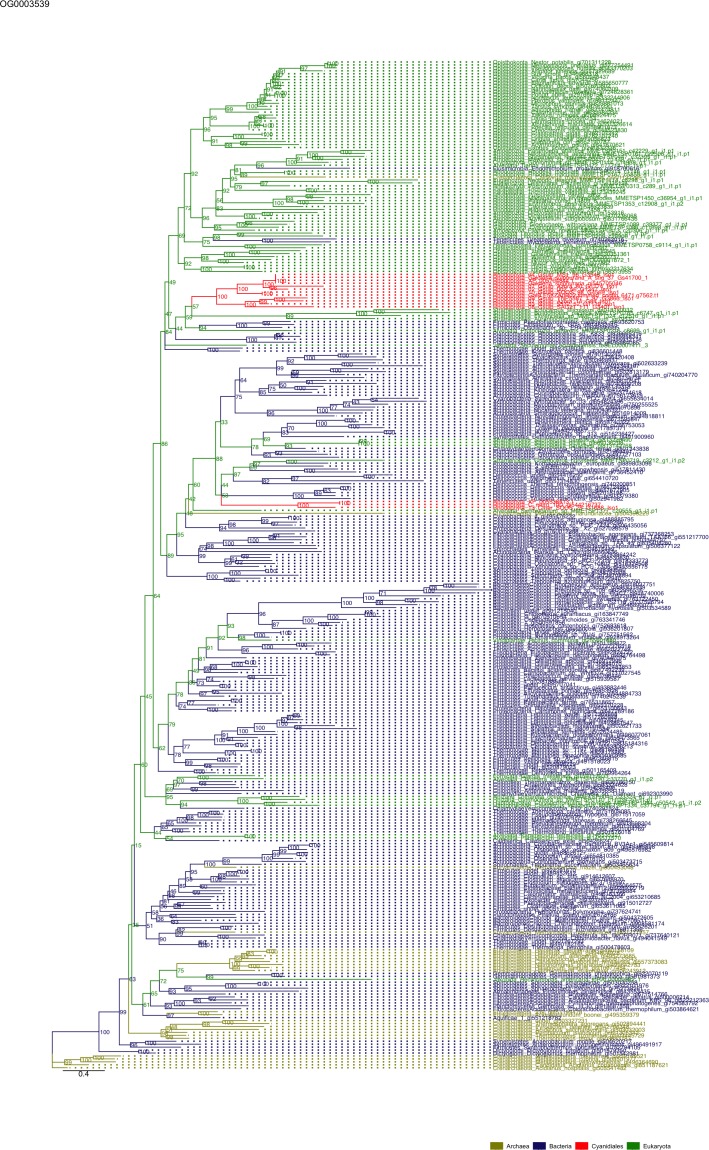
Sequence tree of orthogroup OG0003539.The tree is based on amino acid sequences. Archaea (yellow), Bacteria (blue), Cyanidiales (red), Eukaryotes including other red algae (green). Branches containing Cyanidiales sequences are highlited in red.